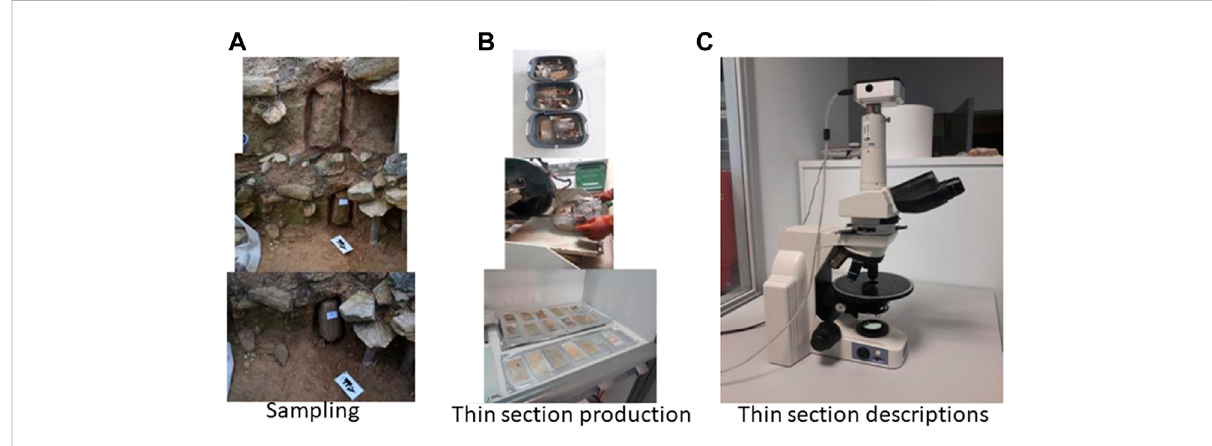
FIGURE 11 Abridged steps of micromorphology analysis: (A) Sampling; (B) Thin section preparation; (C) Thin section